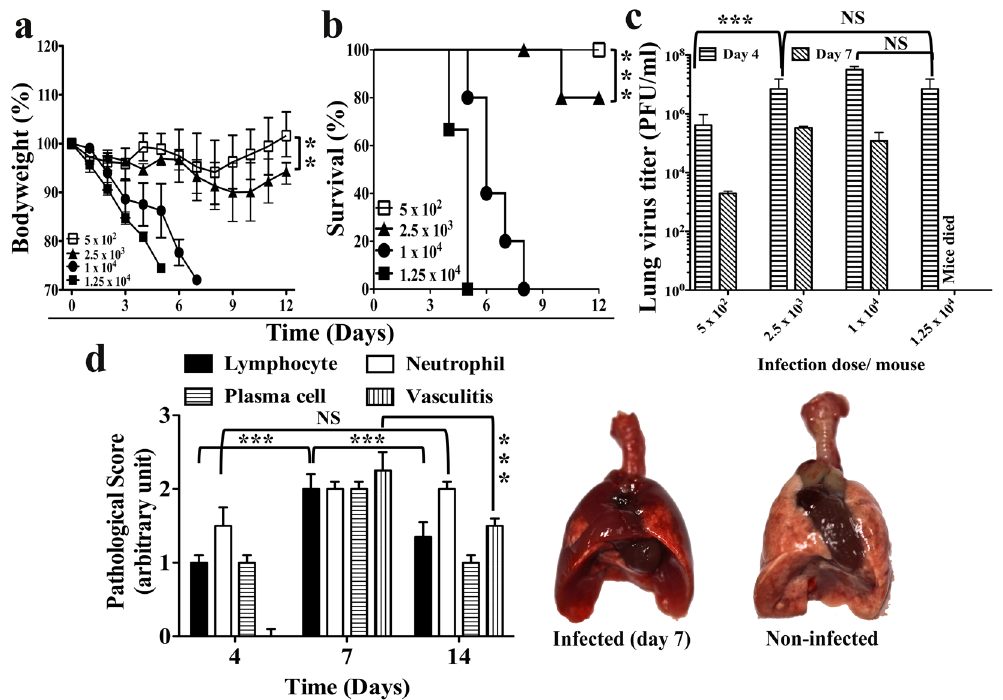
Figure 1. Mouse model of severe influenza virus infection. ( a ) Body weight loss, and ( b ) survival of BALB/c mice following intranasal infection with stated doses of PR8 strain of H1N1 influenza virus. ( c ) Lung virus titer on the stated days post infection with indicated doses of PR8 influenza virus infection in BALB/c mice of same age group. ( d ) Pathological analysis of lung tissue sections (Left panel) and gross lung pathology (Right panel) of BALB/c mice on day 7- post infection following infection with 2.5 × 10 3 PFU of PR8 influenza virus. Data are representative of at least three similar experiments and presented as mean ± s.d. ( *** p < 0.0001; ** p < 0.001; NS = non-significant, p > 0.05; n =